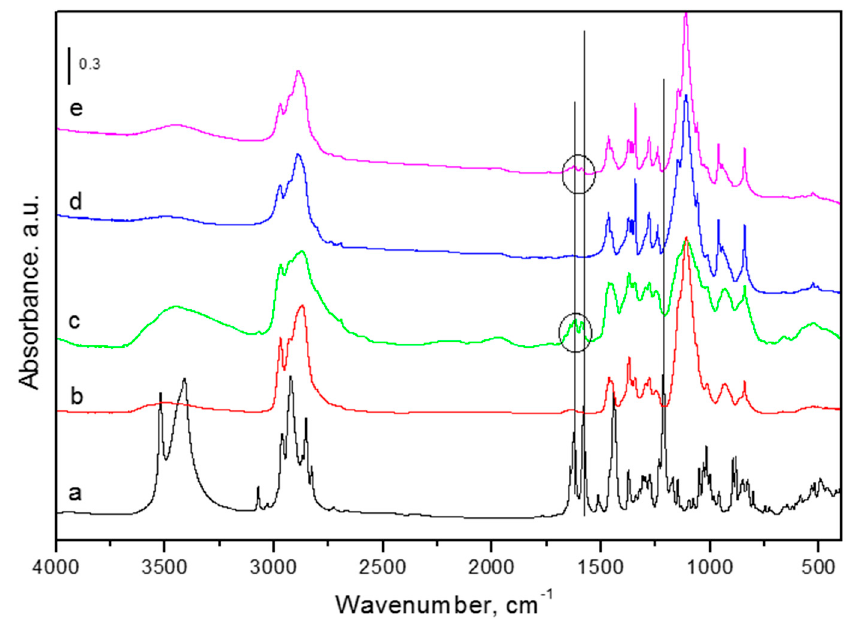
Figure 2. IR spectra of pure cannabidiol (a), empty Pluronic P123 micelles (b), CBD-loaded Pluronic P123 micelles (c), empty (d), and CBD-loaded mixed Pluronic P123/F127 micelles (e).